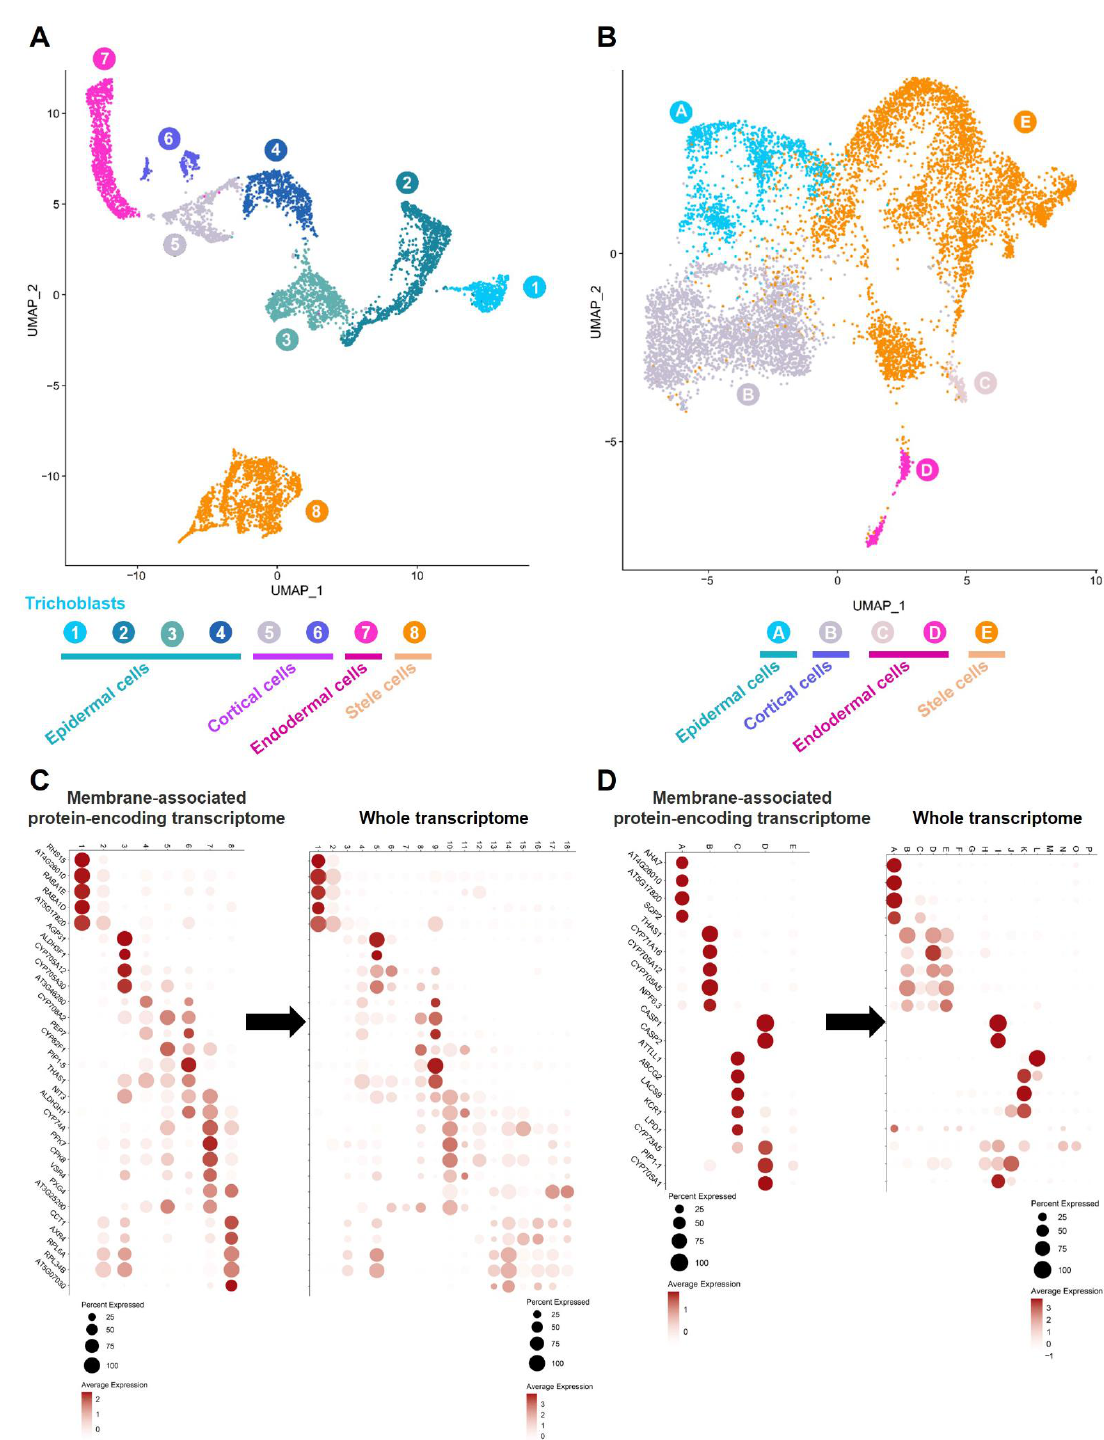
Figure 3. Functional annotation of the Arabidopsis root cell types according to the activity of 965 membrane protein-encoding genes. Both scRNA-seq ( A ) and sNucRNA-seq UMAPs ( B ) were independently annotated. The annotation of the UMAPs was conducted by identifying protoplasts ( C ) and nuclei ( D ) cluster-preferentially expressed membrane-associated protein-encoding genes (Figure 1C), then questioning their activity in the whole transcriptome scRNA-seq and sNucRNA-seq datasets (i.e., Figure 1C). The percentage of nuclei expressing the gene of interest (circle size) and the mean expression (circle color) of the genes are